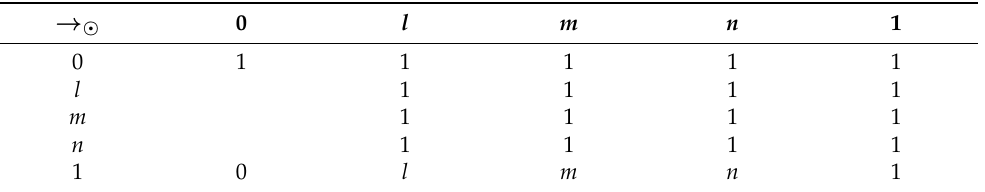
Table 6. The partial operation → (cid:12)